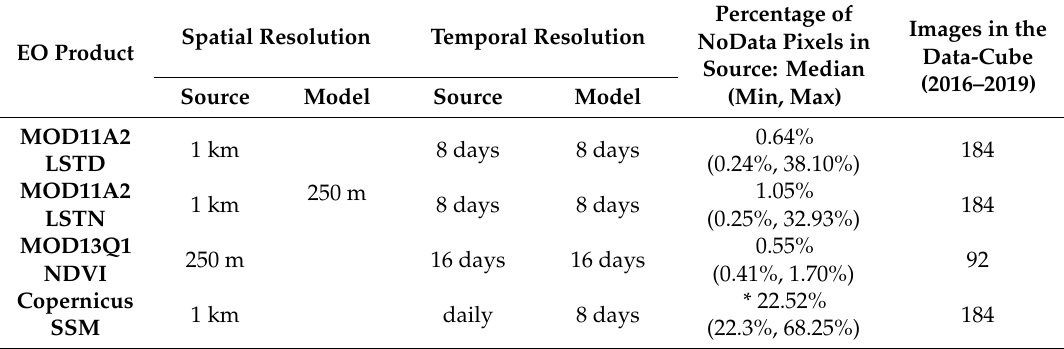
Table 2. Characteristics of the environmental datasets: spatio-temporal resolutions, number of images in the data-cube used for modelling and NoData pixels proportion in the original images.